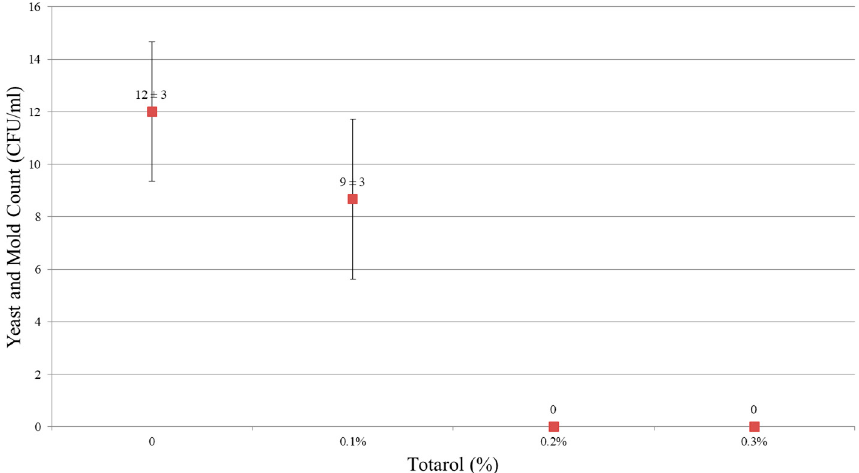
Figure 2. E ff ect of totarol level on yeast and mold counts. Figure 2. Effect of totarol level on yeast and mold counts. Figure 2. Effect of totarol level on yeast and mold counts.